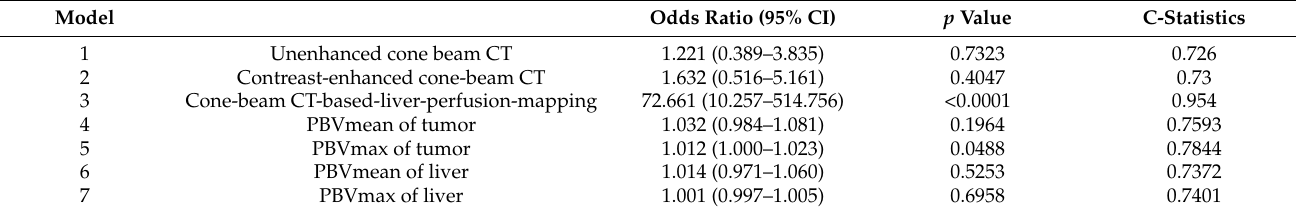
Table 5. Prediction of treatment response according to imaging type and perfusion parameters. Model